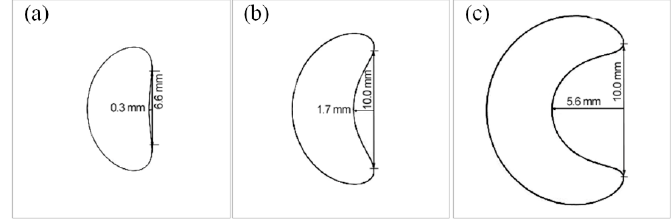
Figure 13. Cross-section shapes of spiral part with different h s ( d s = 12 mm and d w = 5 mm): ( a ) h s = 8.7 mm, θ = 13.0 and BD = 0.09; ( b ) h s = 14.0 mm, θ = 20.2° and BD = 0.3; and ( c ) h s = 20.1 mm, θ = 28.1° and BD = 1.12.